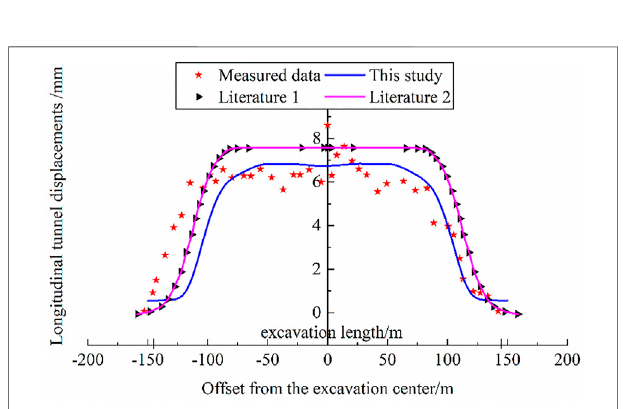
FIGURE7| Resultscomparisonbetweenthismethodandtwostudiesin Case Ⅰ .